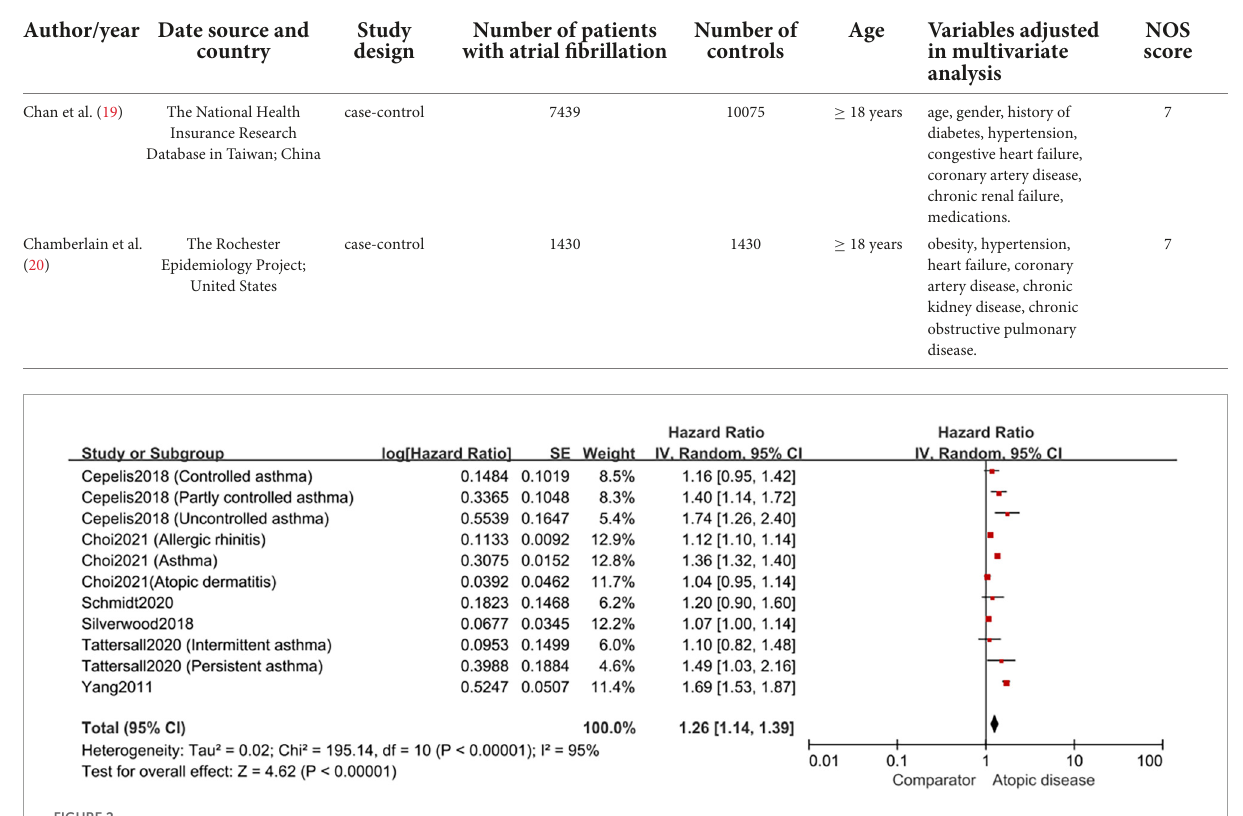
TABLE 2 The baseline characteristics of case-control studies included in the meta-analysis.